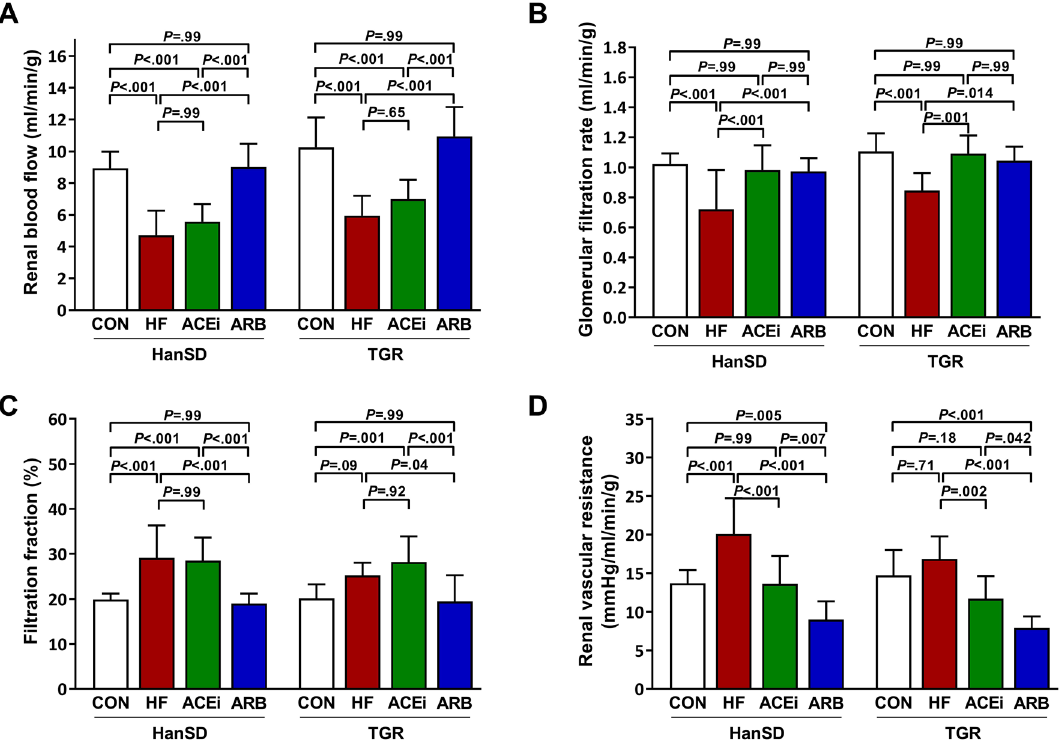
Figure 3. Renal blood flows ( A ), glomerular filtration rates ( B ), filtration fractions ( C ) and renal vascular resistances ( D ) of control (CON), untreated heart failure (HF), ACE inhibitor-treated (ACEi) and AT 1 receptor blocker-treated (ARB) HanSD and TGR rats 20 weeks after sham or ACF operation (5 weeks in HF TGR rats due to high mortality). Data presented as mean ± SD (n = 10 in each increased plasma noradrenaline levels compared to control animals. In TGR rats with ACF, ARB administration was associated with a significant plasma noradrenaline decrease (Fig. 5D). Shown in Fig. 6 are renal levels of angiotensins and renal lactate dehydrogenase (LDH) activity. HanSD rats showed significantly reduced renal ANG I content after ACF placement, and neither treatment further influenced ANG I levels in the kidney. Renal ANG I was significantly suppressed in TGR control and untreated HF rats com- pared to HanSD rats. Both ACEi and ARB treatment significantly raised renal ANG I contents (Fig. 6A). Control TGR rats had renal ANG II levels significantly higher than control HanSD rats. In both rat strains, HF induction caused a significant rise in renal ANG II levels compared to control animals. Rats treated with an ACE inhibitor or AT 1 blocker had significantly suppressed ANG II concentrations in kidneys (Fig. 6B). Rats treated with an ACE inhibitor had a significantly higher renal ANG I/ANG II ratio than untreated HF rats (Fig. 6C). However, as evident from Figs. 5C and 6C, the extent to which ACEi affected the ANG I/ANG II ratio was remarkably lower in the kidney (approx. 3 × higher in ACEi HanSD and 5 × in ACEi TGR rats compared to controls) than in the plasma (approx. 40 × higher in ACEi HanSD and 50 × in ACEi TGR rats compared to controls). We observed significantly increased renal LDH activity in untreated HF rats compared to control rats. In TGR rats, but not in HanSD rats, there was a slight but significant reduction of elevated LDH activity following ACEi treatment. On the other hand, ARB administration led to a significant reduction in LDH activity in both rat strains (Fig. 6D). Markers of oxidative stress, nitrate and nitrite (NOx) urine excretion, and endothelial nitric oxide synthase (eNOS) expression are presented in Fig. 7. 8-isoprostane in urine and renal thiobarbituric acid reactive substances (TBARS) as markers of oxidative stress are shown in Figs. 7A,B, respectively. We observed a rise in oxidative stress in untreated rats with HF. ACE inhibitor treatment did not significantly influence renal oxidative stress compared to untreated ACF rats of both rat strains, except for ACF TGR rats, in which ACEi significantly reduced renal TBARS. However, HF-induced increase in markers of oxidative stress was ameliorated by blocking the AT 1 receptor. Urine NOx trended to be lower in untreated HF and ACEi-treated HanSD rats. In TGR rats, urine NOx excretion was significantly reduced in untreated HF and ACEi-treated HanSD rats. In contrast, ARB treatment led to a restoration of NOx excretion (Fig. 7C). Rats with HF showed significantly increased expression of eNOS in the kidney compared to control animals. ACEi adminstration was not associated with significant changes in eNOS expression. In contrast, eNOS expression was significantly suppressed during AT 1 receptor inhibition in TGR rats (Fig. 7D). Original unprocessed Western blots from Fig. 7E are shown in Supplementary Fig. 1.